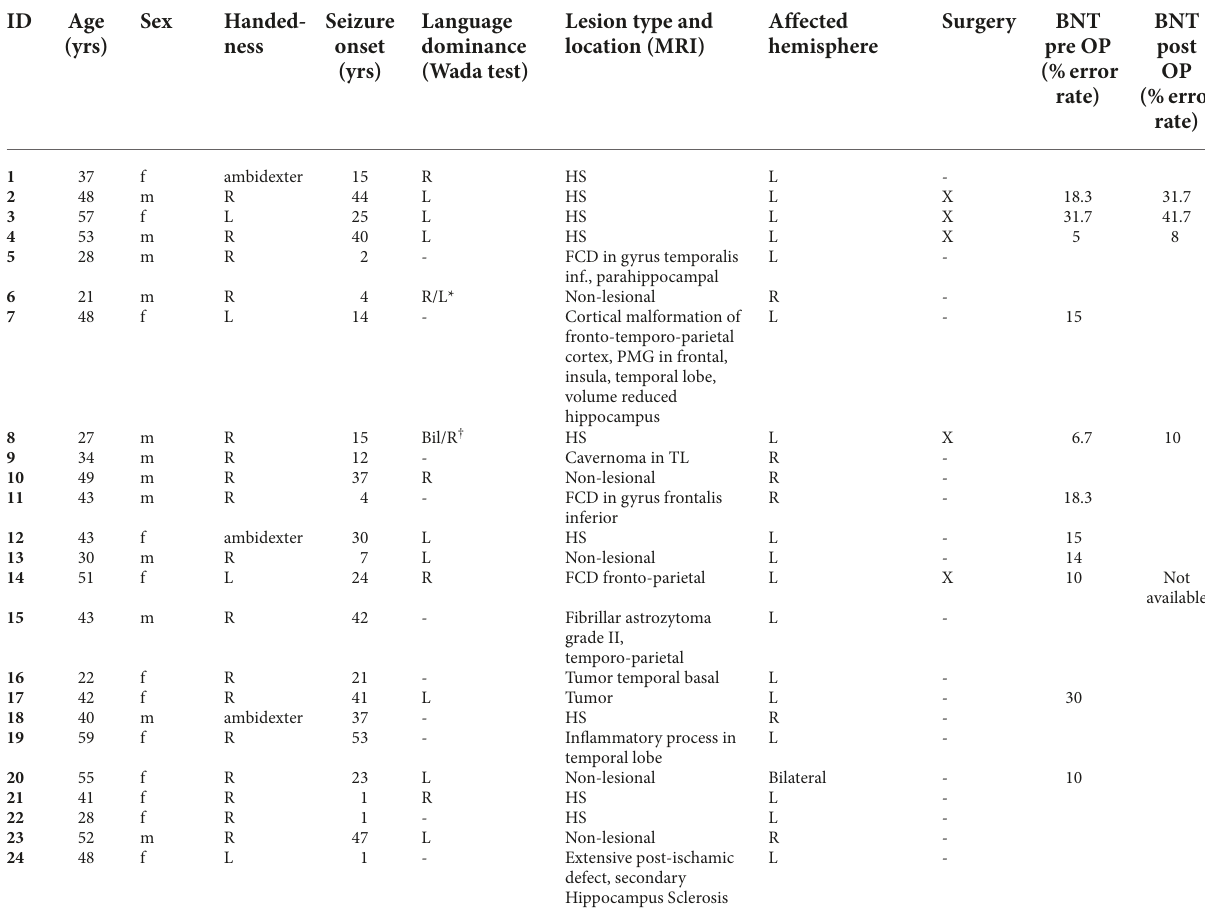
TABLE 1 Demographics and clinical characteristics of the patient